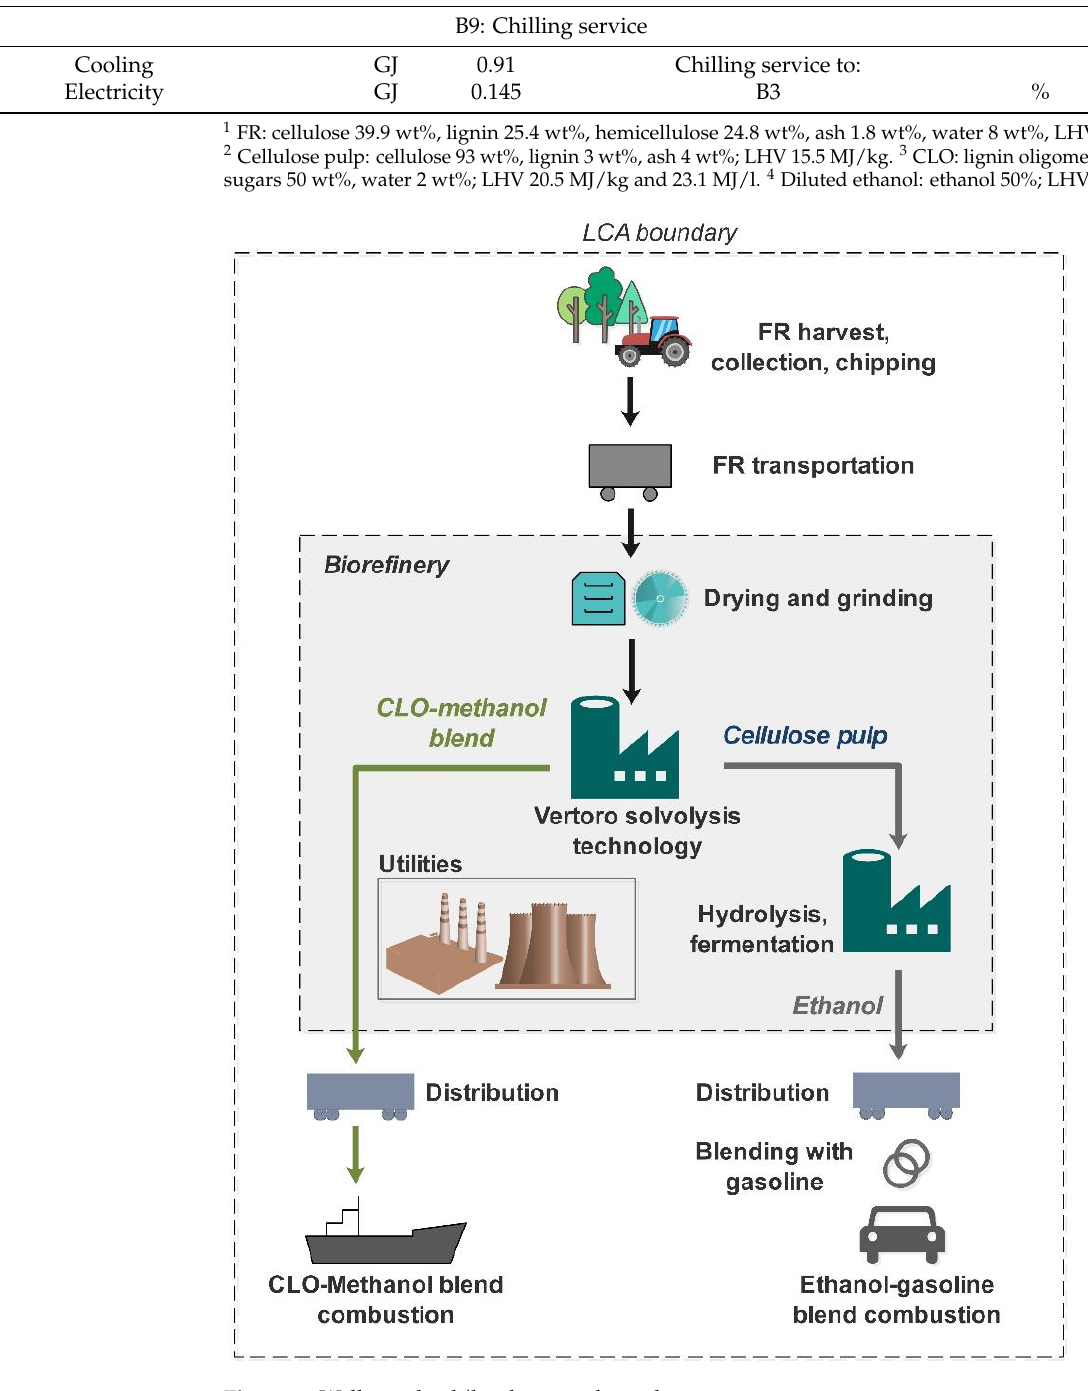
Figure 2. Well-to-wheel/haul system boundary.